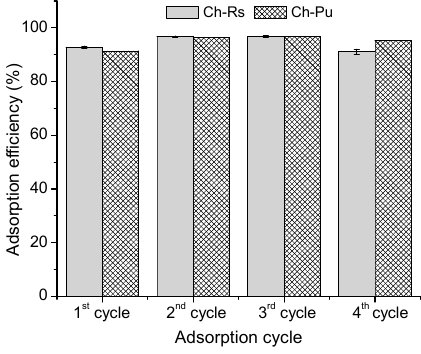
Figure 12. As(V) adsorption cycles of Ch–Rs and Ch–Pu blends.